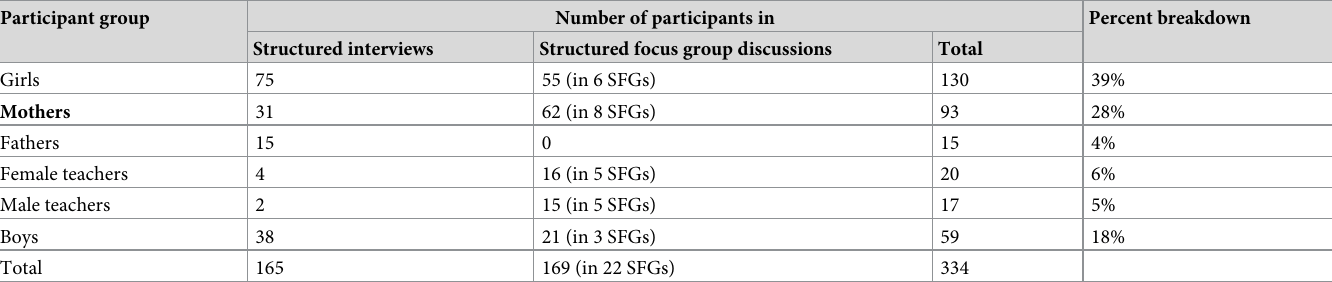
Table 2. Participant enrollment and participation